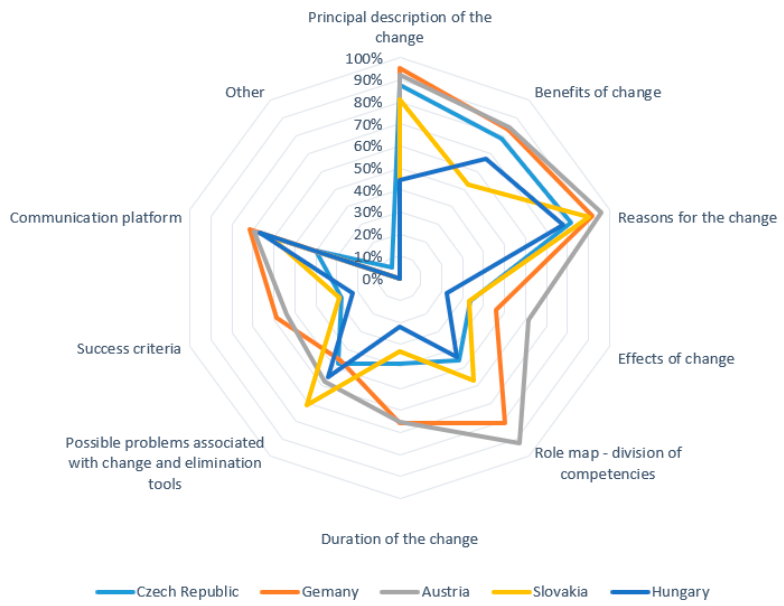
Figure 5. Information provided about the change to the involved persons.